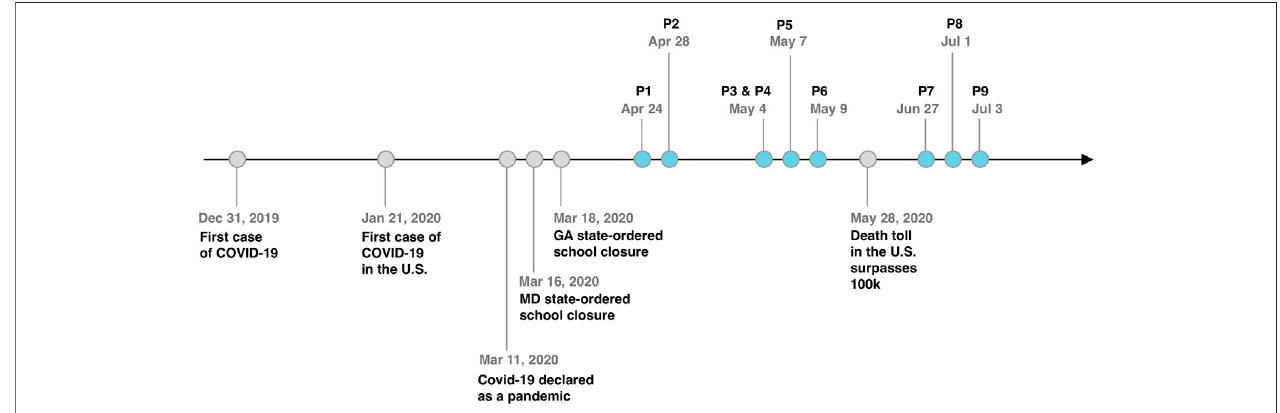
FIGURE 1 | A timeline of interviews and major events related to